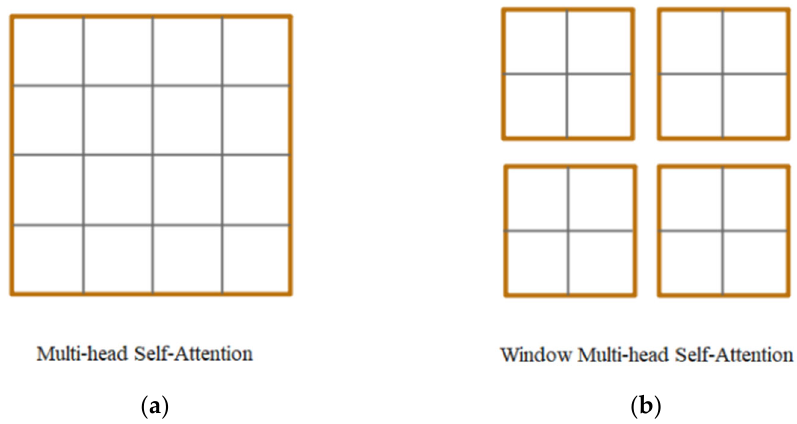
Figure 2. ( a ) Normal multi ‐ head self ‐ attention; ( b ) windows multi ‐ head self ‐